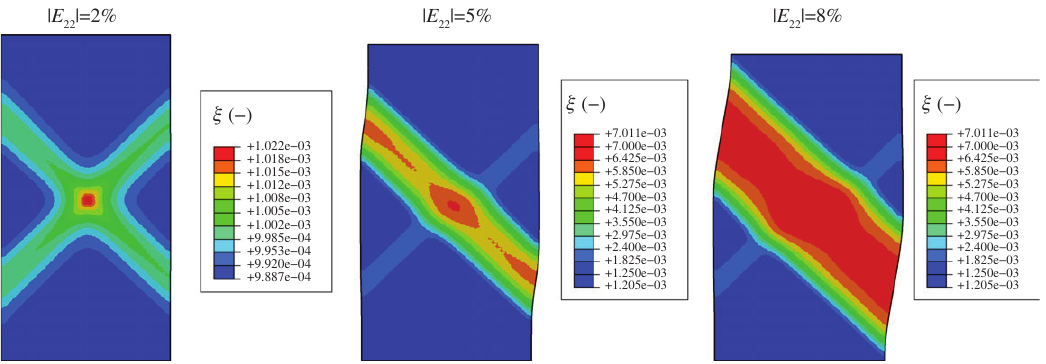
Figure 4 Sample S , general model behavior: spatial distribution of free volume ξ at three applied compression strains | E 1